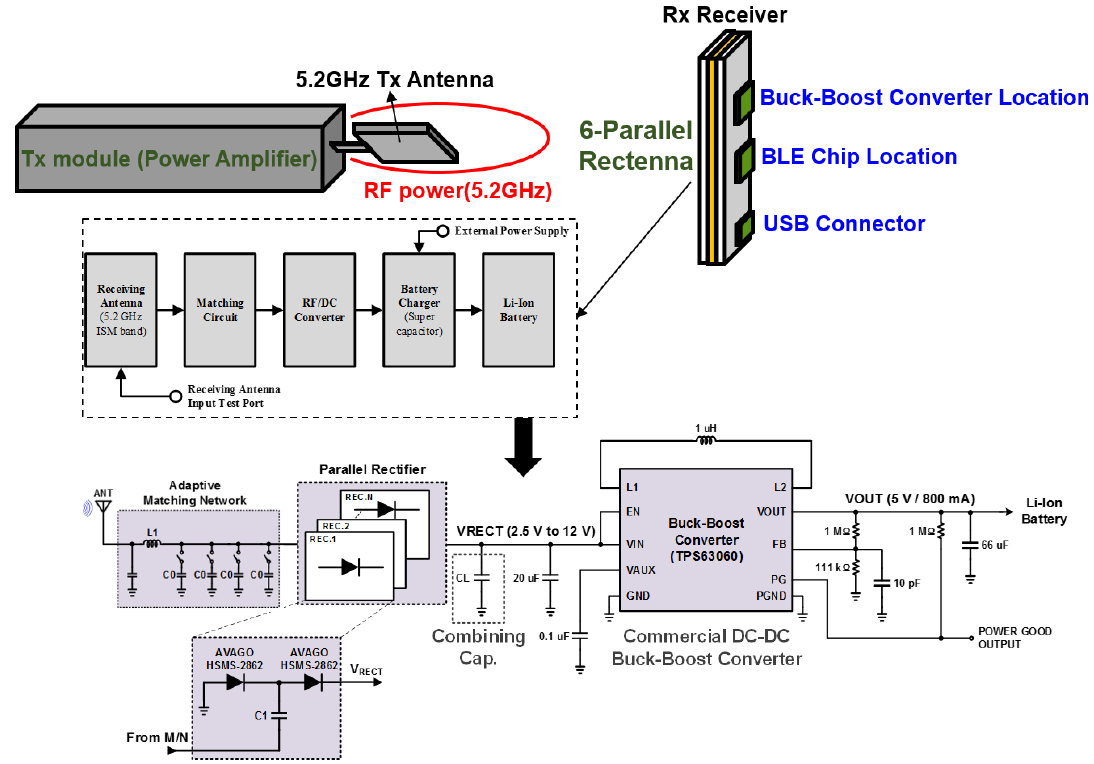
Figure 3. The proposed RF energy harvester system block diagram. Reprint with